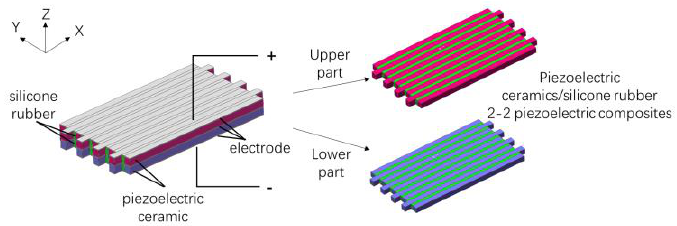
Figure 1. Structure of the double-harmonic piezoelectric composite lamination.